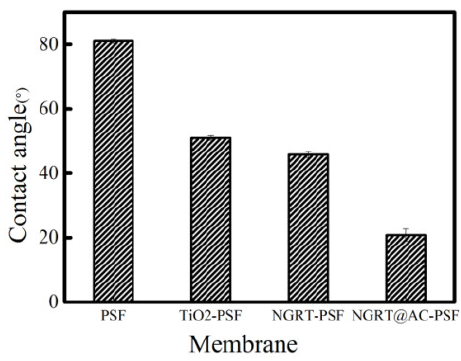
Figure 6. The water contact angles of the membranes.